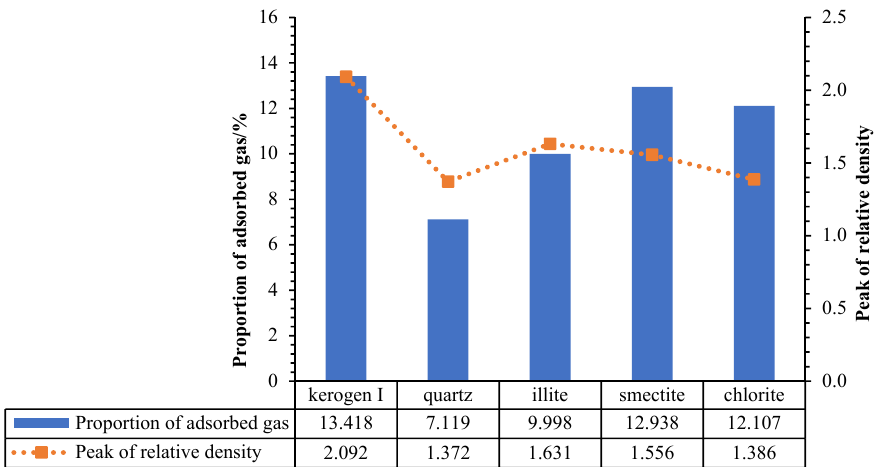
Figure 3. The proportion of excess adsorption amount and peak of relative density in the pores of different minerals. Kerogen I (13.418%) > smectite (12.938%) > chlorite (12.107%) > illite (9.998%) > quartz (7.119%).